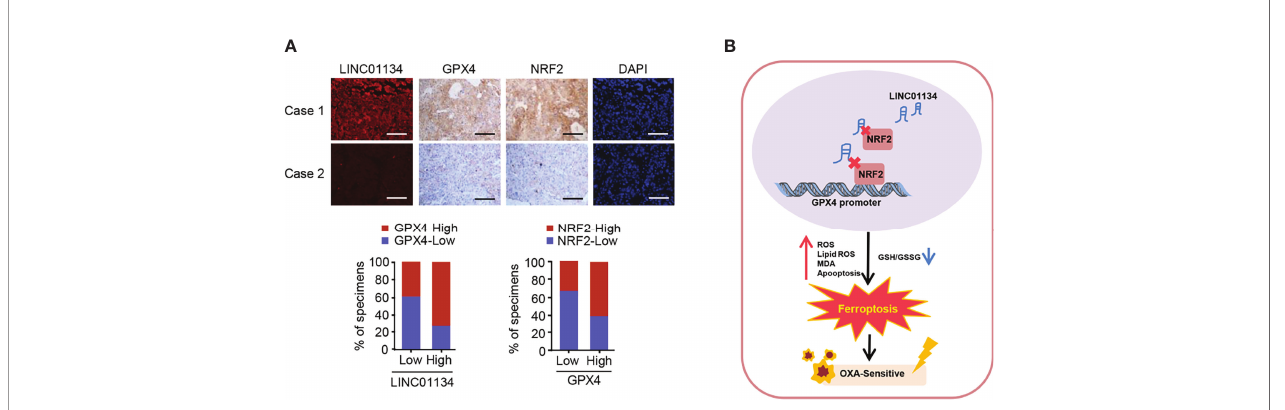
FIGURE 5 | The relevance between the LINC01134 and GPX4 expression and the relationship between Nrf2 and GPX4 in liver cancer patients. (A) FISH staining for LINC01134 and representative IHC staining for GPX4 and Nrf2 in HCC patients with high or low LINC01134 expression. Scale bar, 50 m m. (B) Suggested pattern diagram for the function of the LINC01134 in oxaliplatin resistance by regulating ferroptosis of